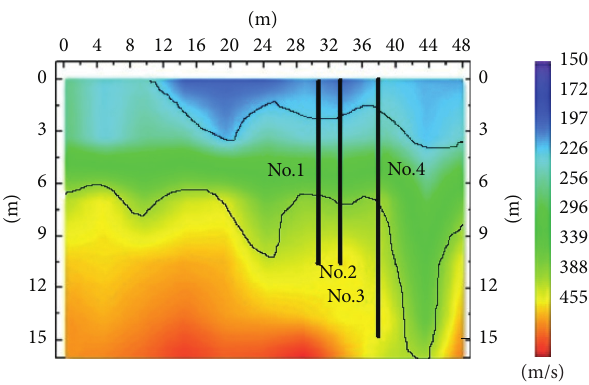
Figure 1: Profile of shear wave velocity on site